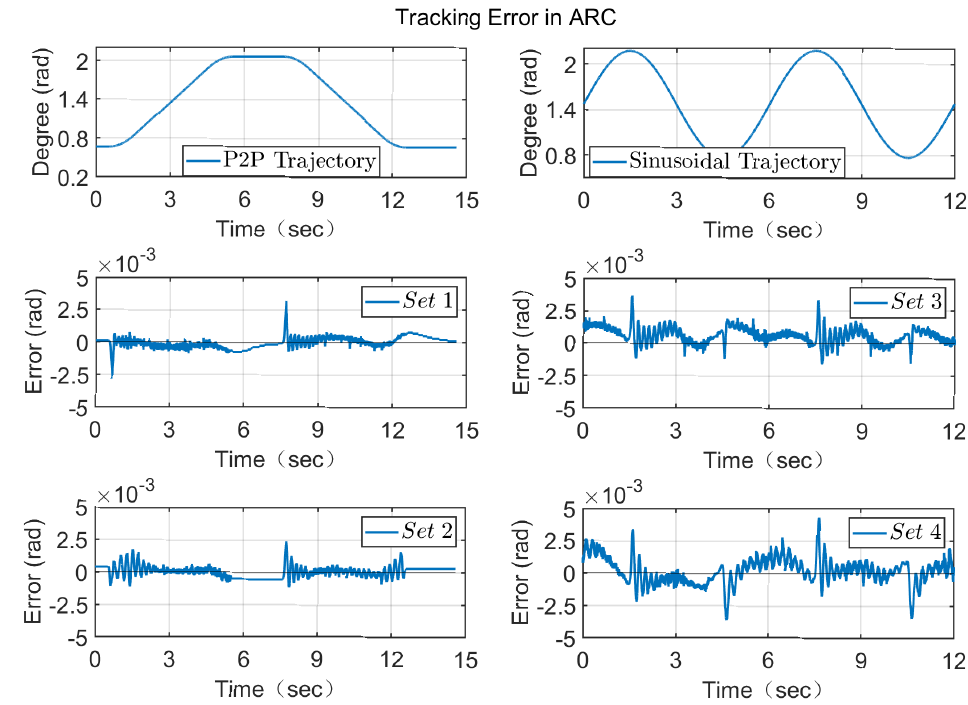
Figure 13. The tracking error comparison of ARC in different